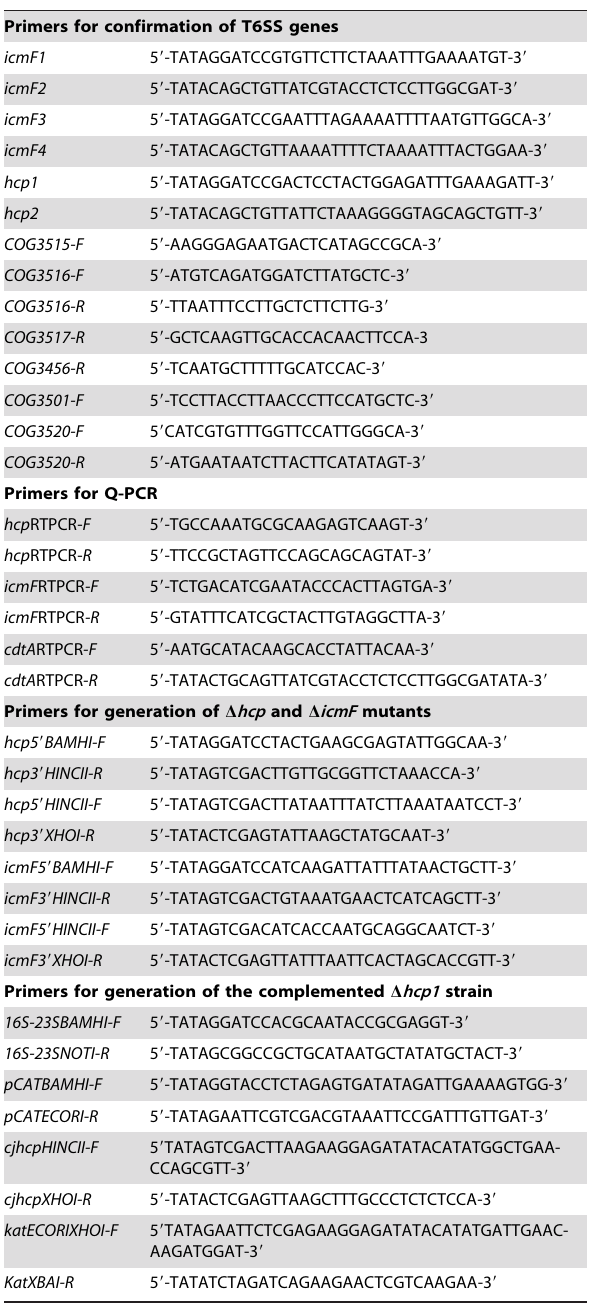
Table 3. Primers used in this